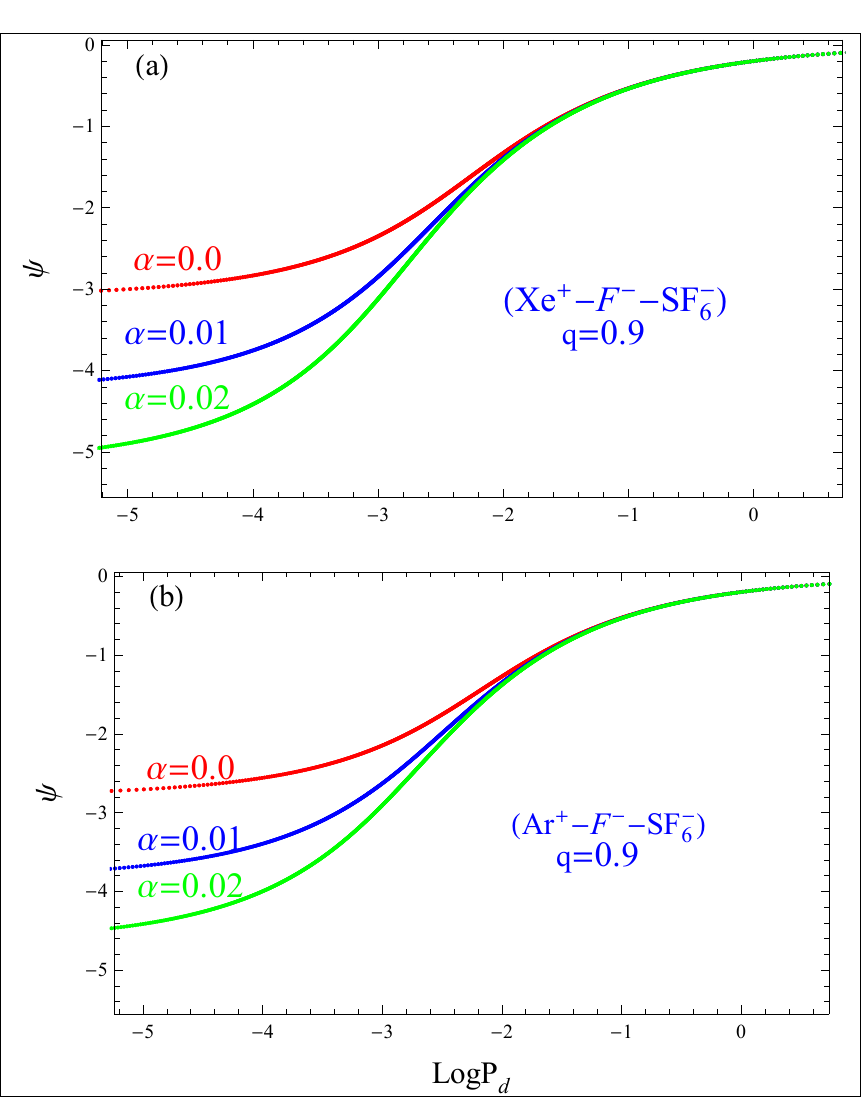
Figure 2. (Color online) ψ versus P d for α ( 0.0,0.01,0.02 ) with q = 0.9; ( a ) xenon–fluorine–sulfur hexafluoride as given in Equation (10) ( b ) for argon–fluorine–sulfur hexafluoride plasma as given in Equation (14)